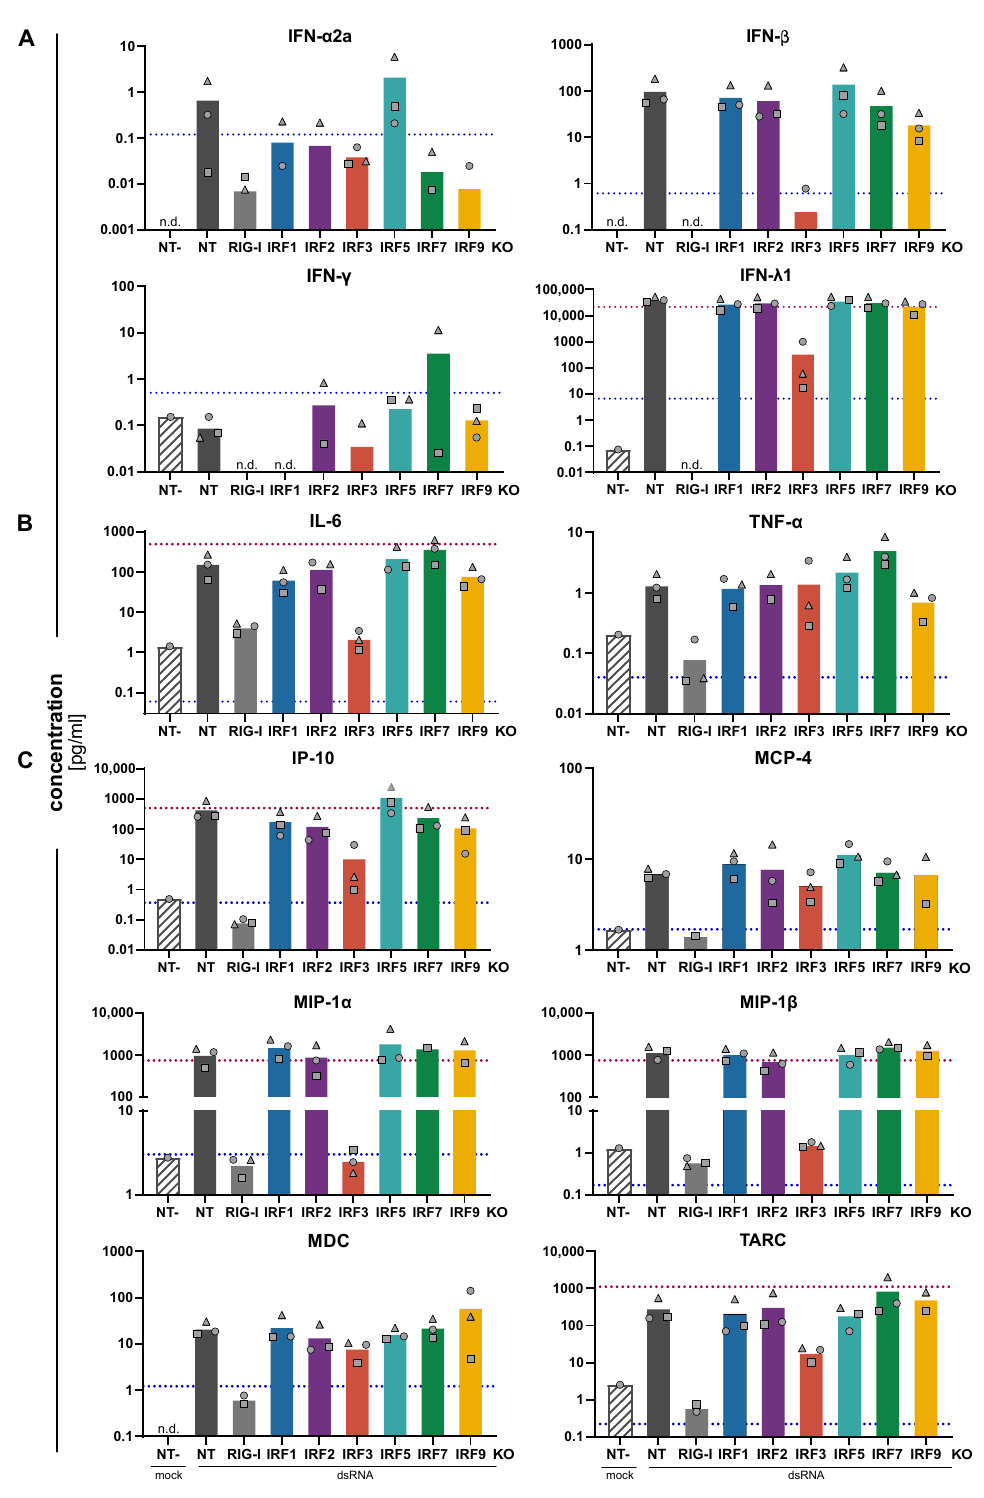
Figure 4. Cytokine and chemokine production of IRF KO cell lines upon stimulation of RIG-I. A549 NT , A549 RIG-I KO , and A549 IRF (as indicated) KO cells were stimulated by transfection of the RIG-I agonist 5’ppp-dsRNA (1 ng/well) for 24 h. Concentrations of indicated ( A ) IFNs, ( B ) proinflammatory cytokines and ( C ) chemokines in the cell culture supernatants were assessed by electroluminescent multiplex assays. “NT-” denotes the unstimulated (mock transfected) control condition. Bars represent the mean of three biologically independent experiments, with the three individual data points shown as gray symbols (same shapes represent same experiment); missing symbols indicate “non-detectable” measurements. Dashed lines represent the lower (blue) and upper (red) limit of quantification of the